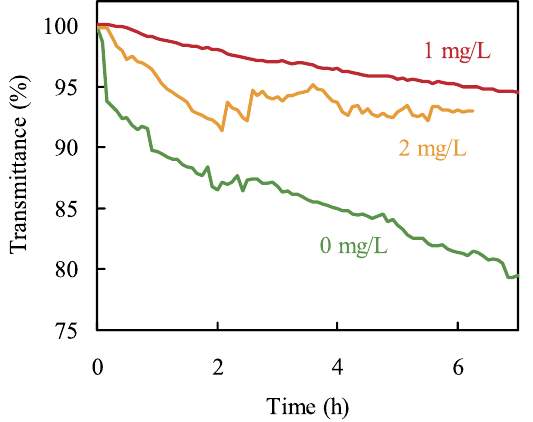
Figure 5. Effect of the polycarboxylic acid inhibitor on the scale formation monitored by the fiber optic sensor. Exposed core length: 24 cm; wavelength: 600 nm; inhibitor concentration: 1 mg/L (red line), 2 mg/L (yellow line), and 0 mg/L (green line).